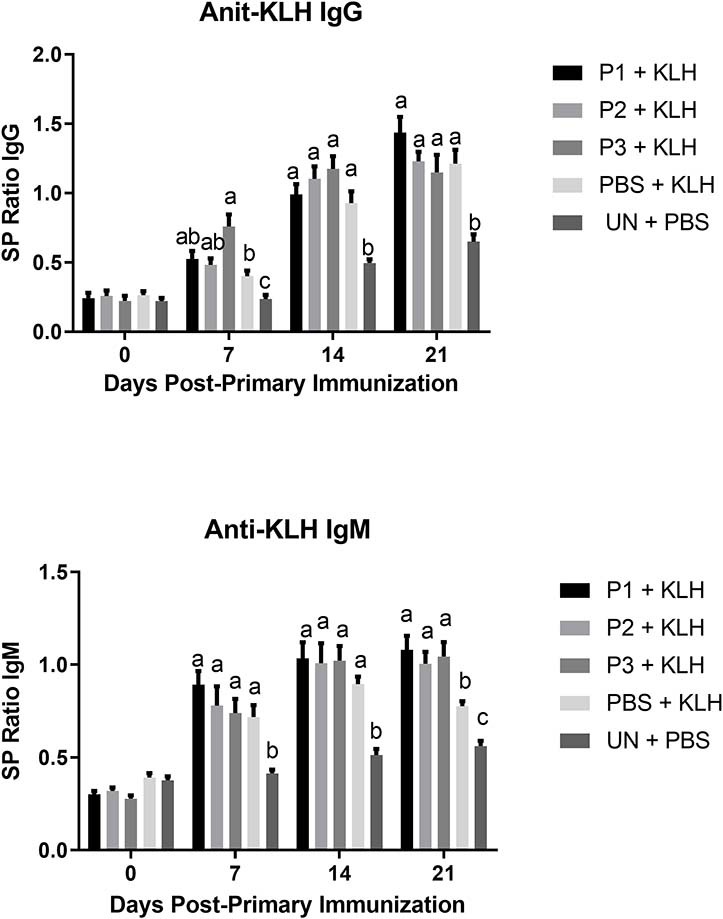
Serum anti-KLH IgG and IgM titers as determined by indirect ELISA. Treatment groups were as follow: P1, P2, and P3 received 1 × 105, 1 × 106, 1 × 107 CFU/egg of a selected mixture of Lactobacillus bacteria (L. salivarius, L. reuteri, L. crispatus, and L. johnsonii), respectively and immunized with KLH (P1 + KLH, P2 + KLH, and P3 + KLH); chickens received 100 μl of phosphate-buffered saline/egg and were immunized with KLH (PBS + KLH); and chickens from non-injected eggs that were injected with PBS served as control group (PBS). Serum samples collected from 12 birds per treatment. Statistical significance among treatment groups was calculated using one-way ANOVA followed by Tukey's comparison test. Error bars represent standard errors of the mean. Results were considered statistically significant from the control group if P < 0.05. (a–c) Means with no common superscripts differ significantly.